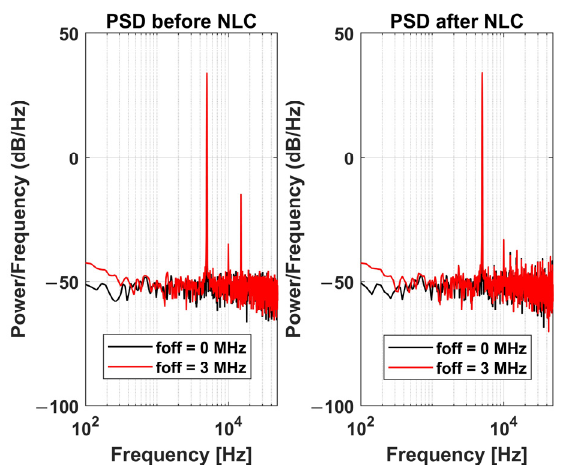
Figure 4. Power spectral density simulation of the output of the proposed offset compensation architecture before and after non-linearity correction with R = 0.125 and L = 512.